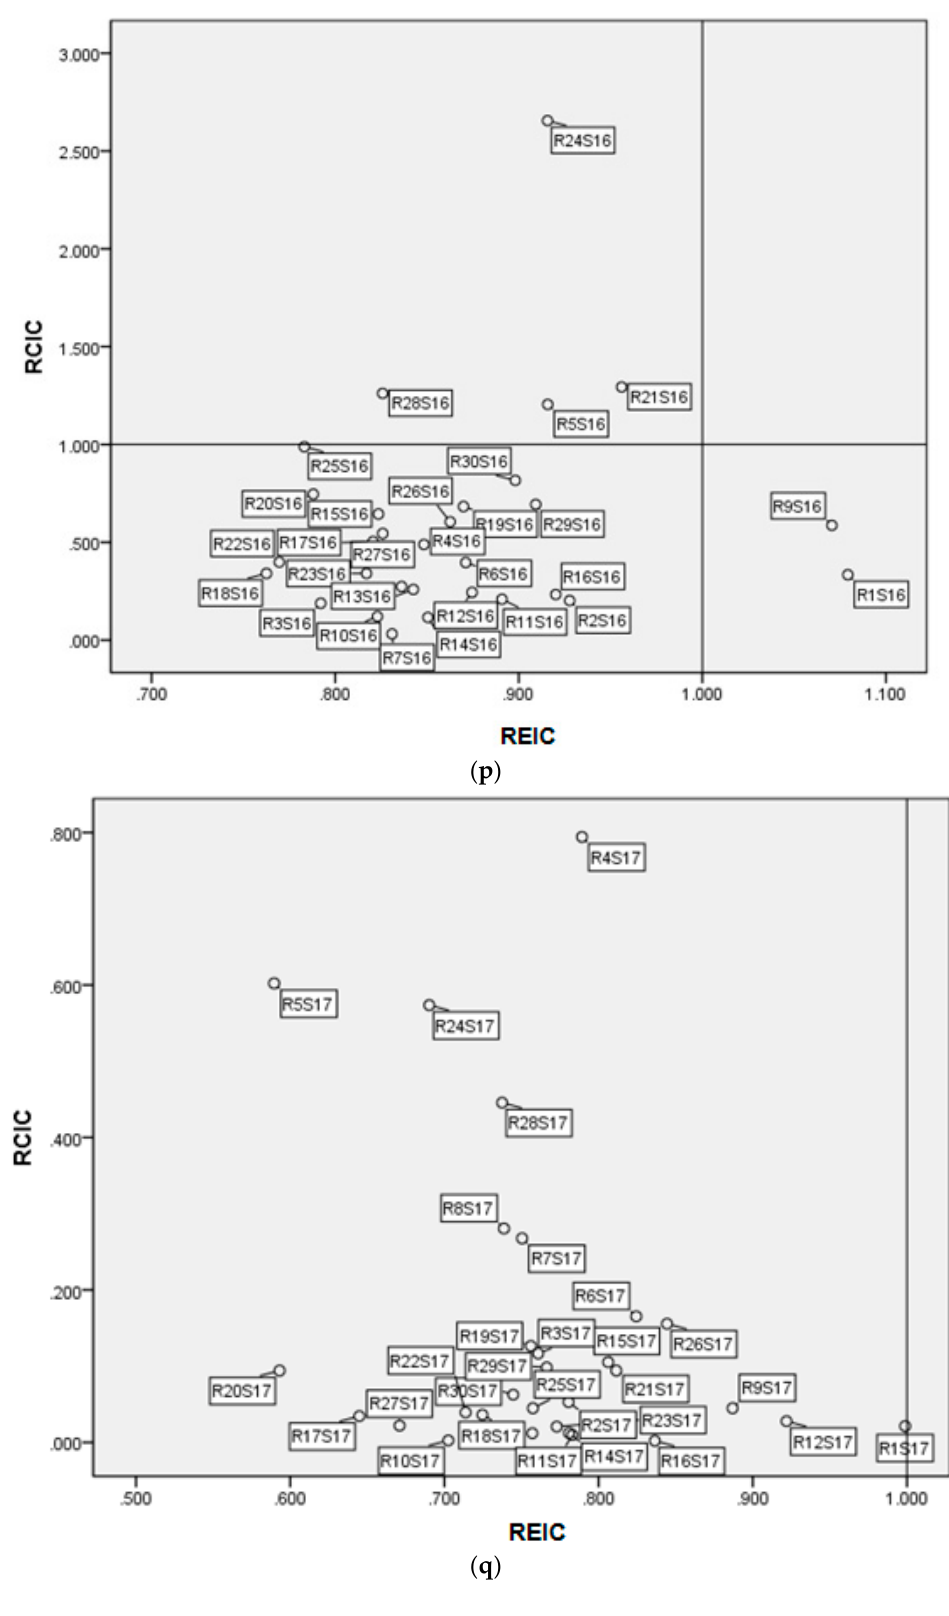
Figure A3. ( a ) Economic and CO 2 emission performance of the agricultural sector (S1) in China’s 30 regions; ( b ) Economic and CO 2 emission performance of the mining sector (S2) in China’s 30 regions; ( c ) Economic and CO 2 emission performance of the food and tobacco processing sector (S3) in China’s 30 regions; ( d ) Economic and CO 2 emission performance of the textile and related products manufacturing sector (S4) in China’s 30 regions; ( e ) Economic and CO 2 emission performance of the